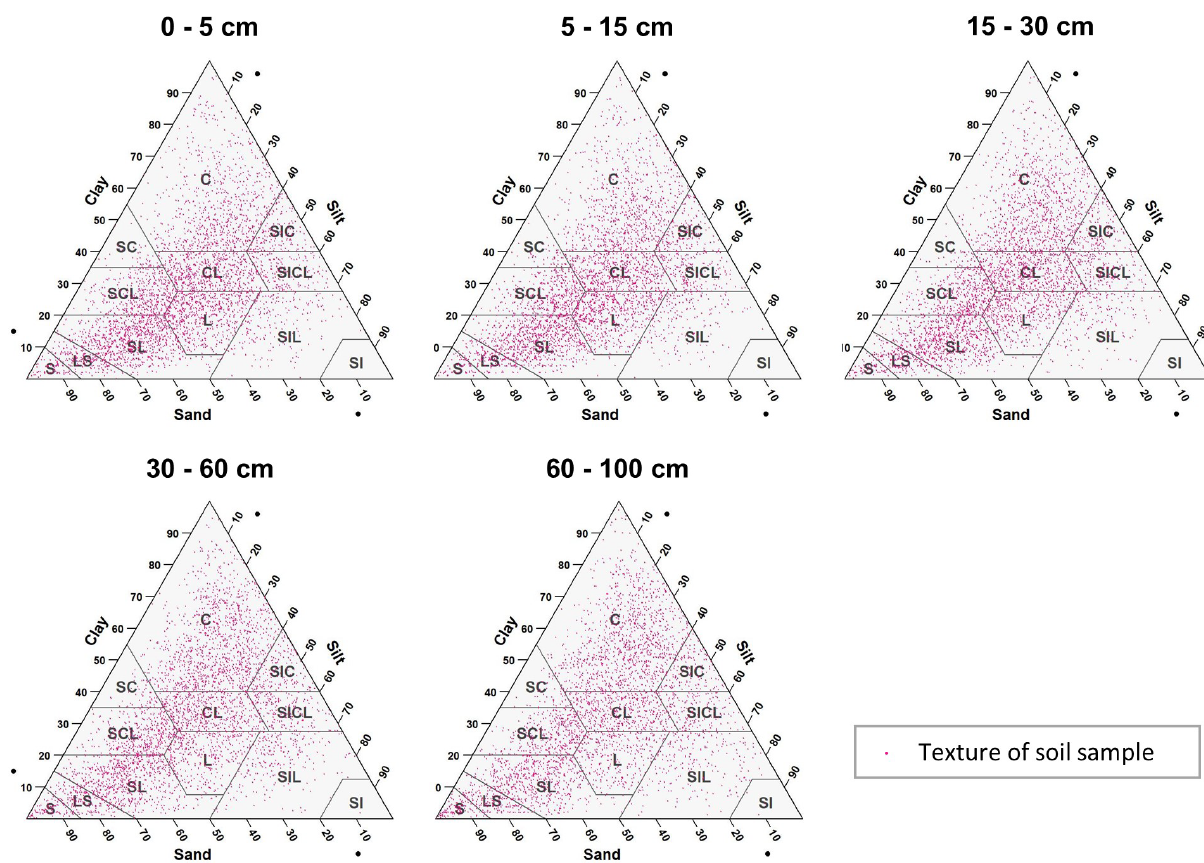
Figure 3. Particle size soil samples representation in a textural diagram for each standard depth. C: clay, SC: sandy clay, SCL: sandy